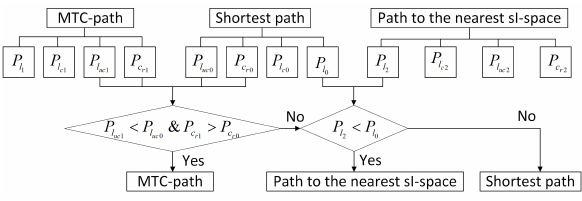
Figure 3. The path selection strategy. The shortest path is computed based on the original weights ( W (cid:48)